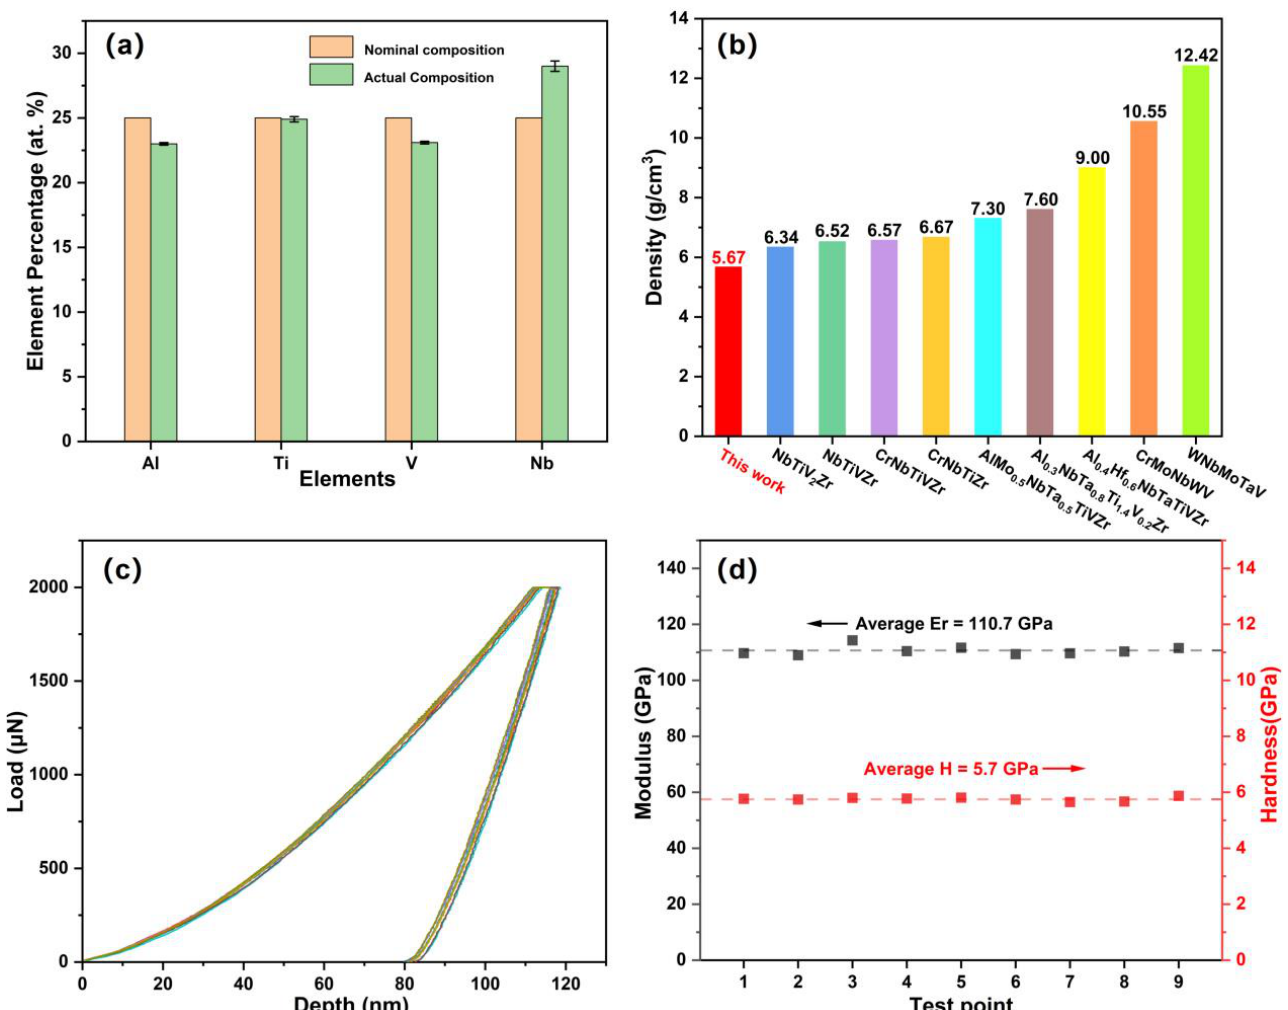
Figure 2. ( a ) The element percentage (at. %) of the AlTiVCr HEA film; ( b ) The density of the AlTiVCr HEA film analogous to HEAs including NbTiV 2 Zr [26], NbTiVZr [26], CrNbTiVZr [26], CrNbTiZr [26], AlMo 0.5 NbTa 0.5 TiVZr [26], Al 0.3 NbTa 0.8 Ti 1.4 V 0.2 Zr 1.3 [27], Al 0.4 Hf 0.6 NbTaTiVZr [27], CrMoNbWV [28], and WNbMoTaV HEAs [28]; ( c ) The load–depth curves of the AlTiVCr HEA film; ( d ) The corresponding modulus and